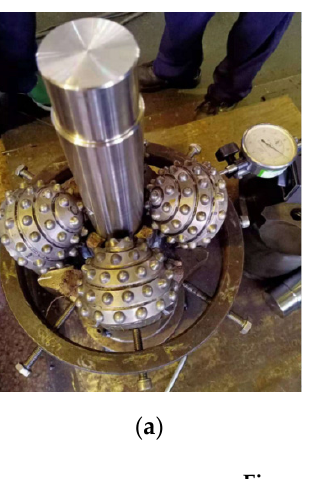
Figure 4. ( a ) Optimization of roller core bit; ( b ) Installation of the roller core bit in the sea test; ( c ) Sea test of the roller core bit.